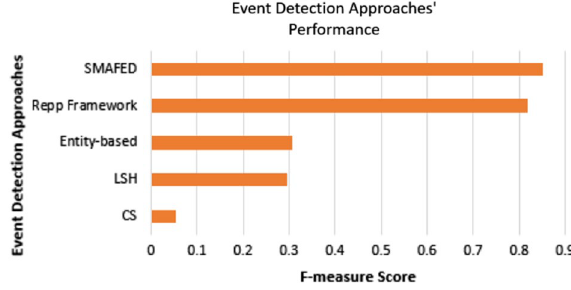
Fig. 6 The comparison of F-Measure score for event detection